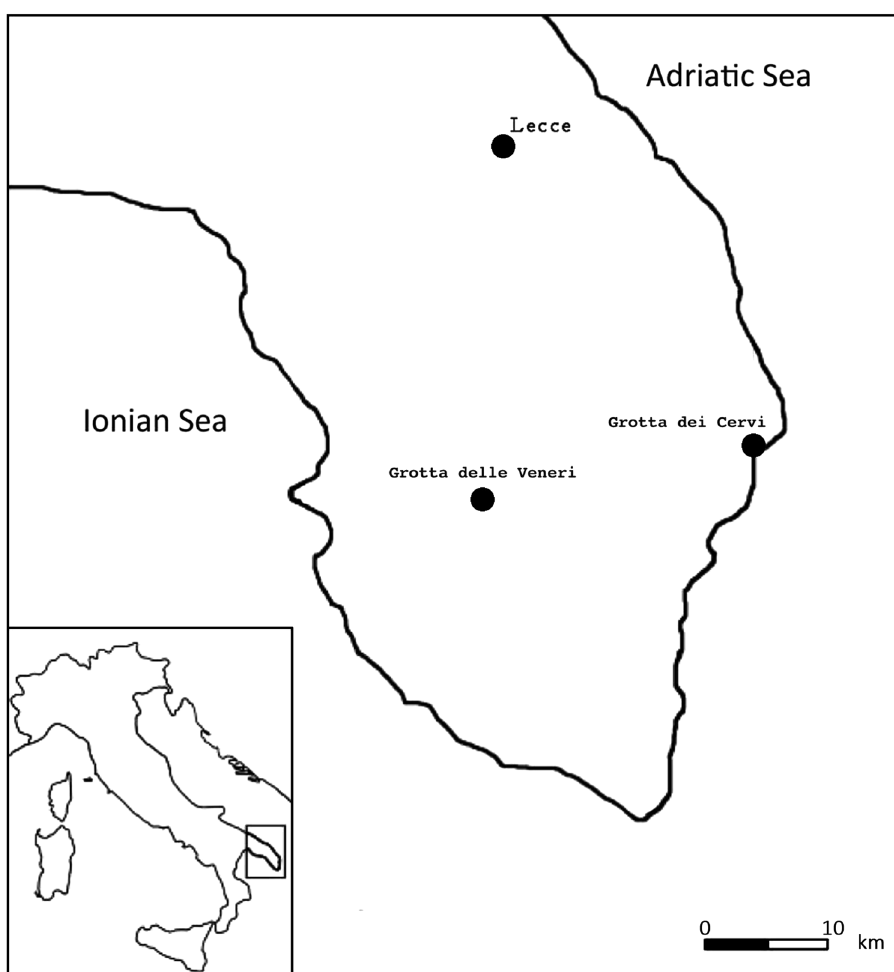
Figure 1: Location of Grotta dei Cervi and Grotta delle